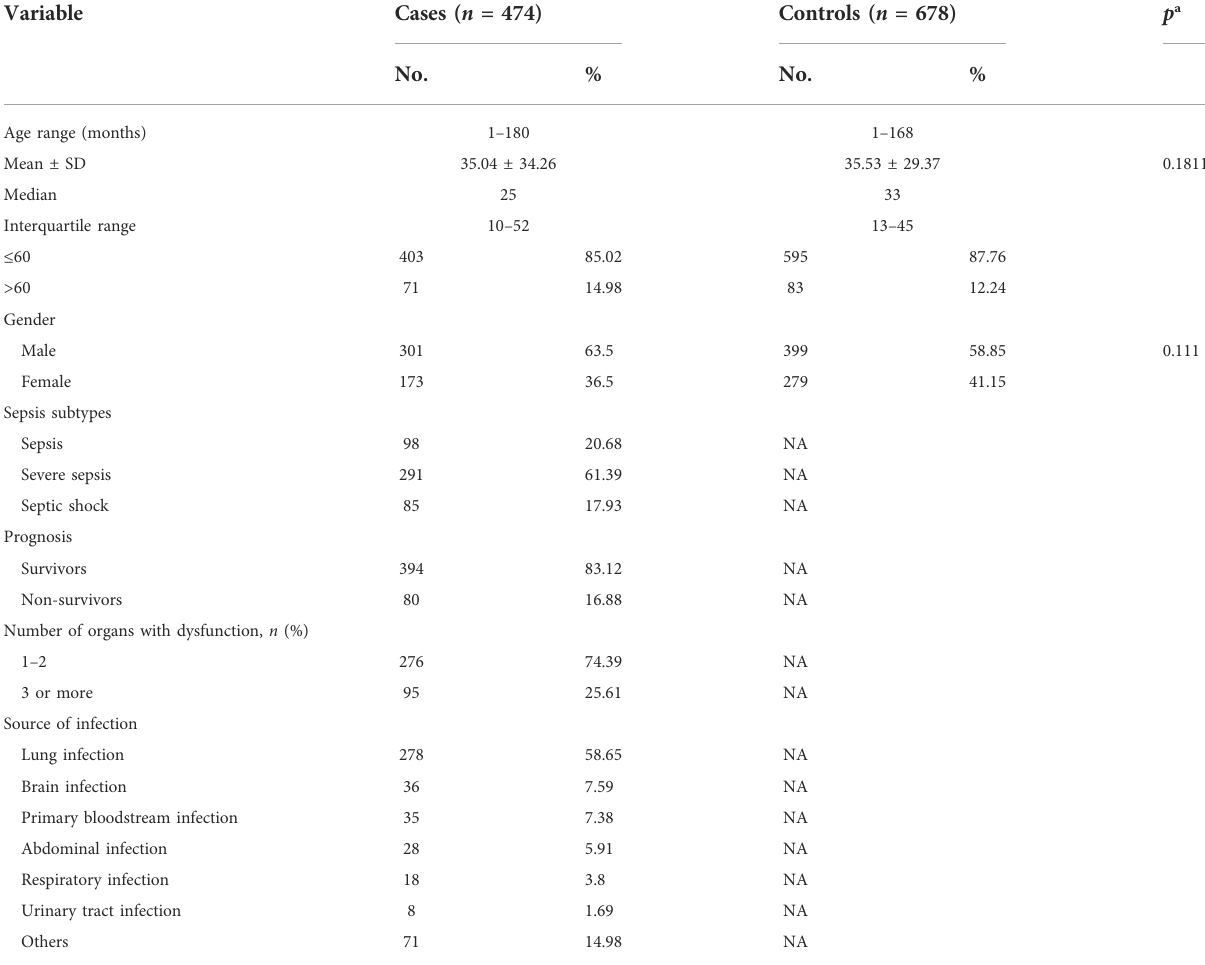
TABLE 2 Frequency distribution of selected characteristics in sepsis cases and healthy